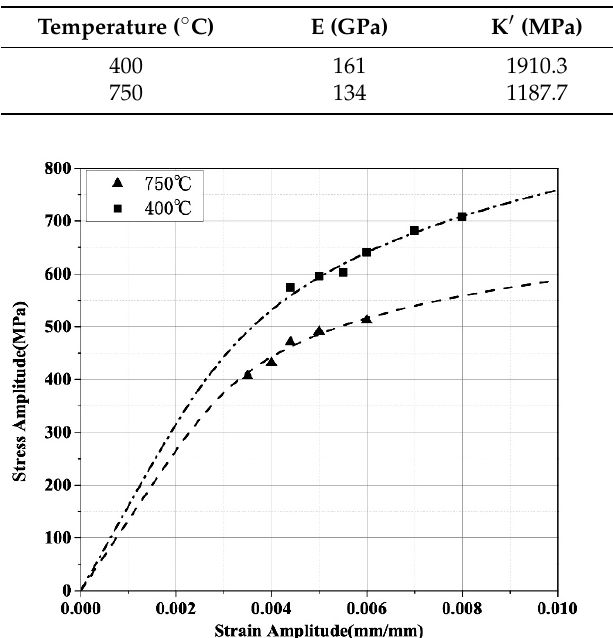
(cid:2868).(cid:2870)